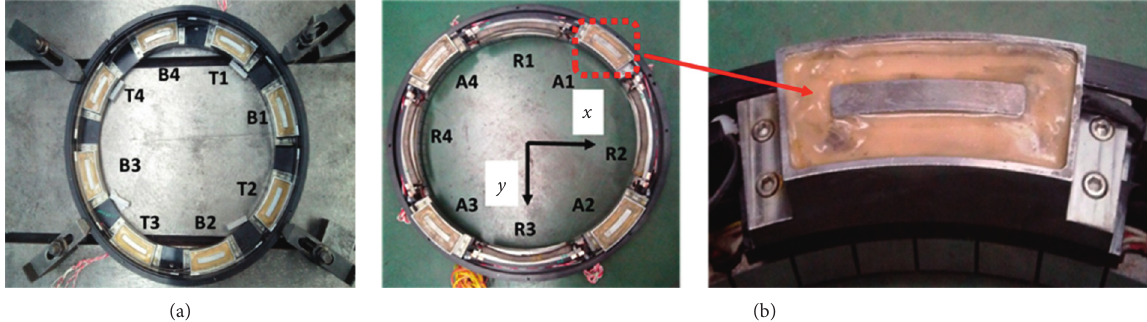
Figure 4: The axial AMB system. (a) Axial AMB at lower end. (b) Axial AMB at upper end and the single AMB.